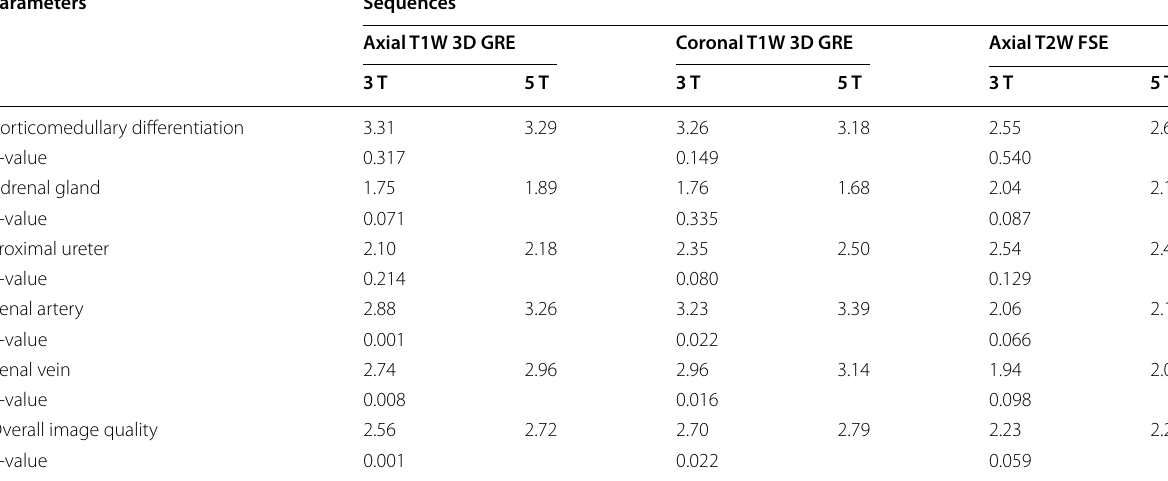
Table 3 Average scores of qualitative image analysis for anatomical imaging at 3 T and 5